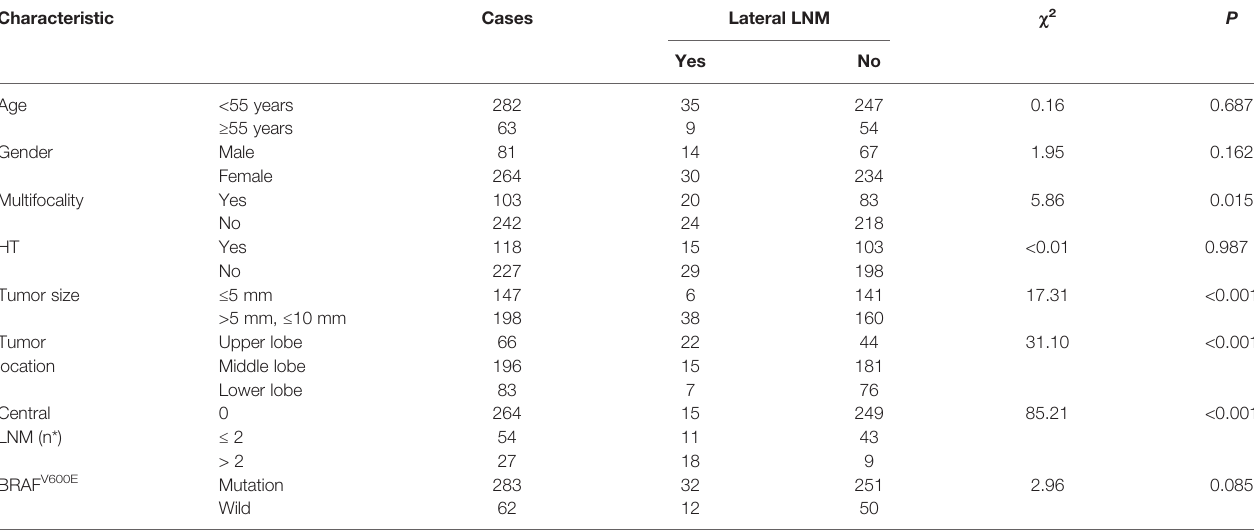
TABLE 2 | Univariate analyses of factors related to lateral LNM in 345 cases of T1a PTC.